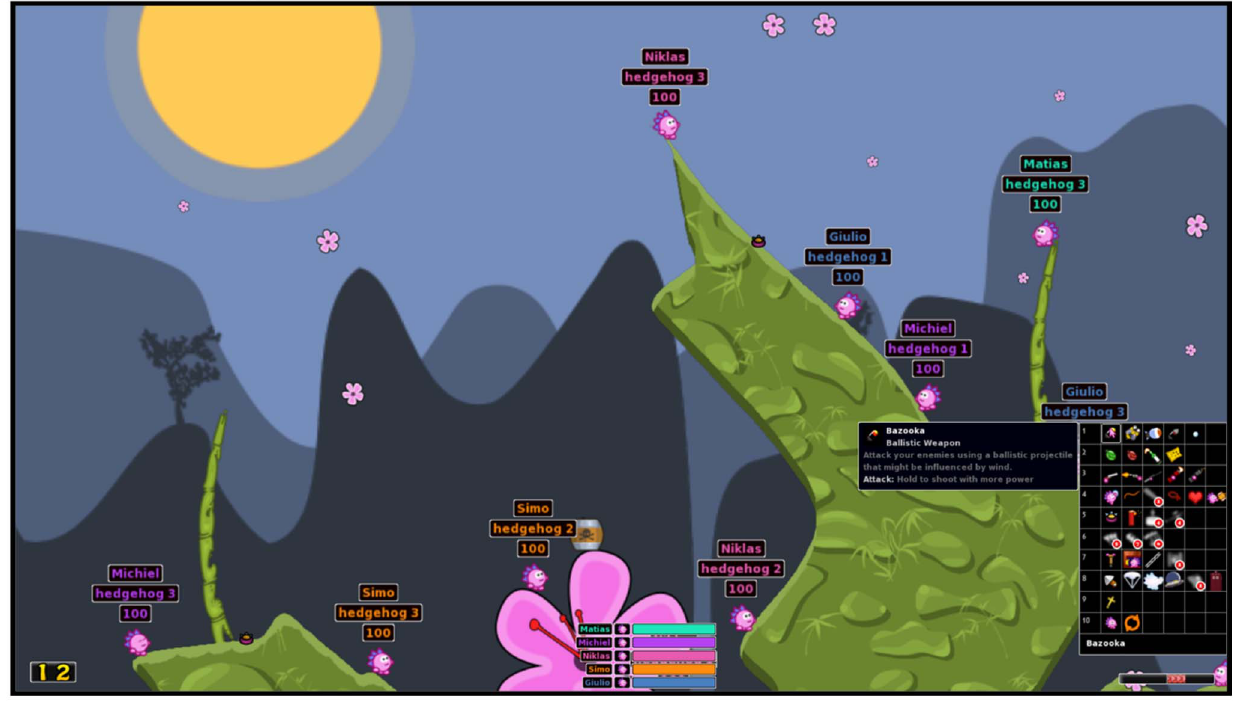
Figure 1. A screen-capture of Hedgewars. Participants commanded teams of hedgehogs and engaged in ballistic shooting (weapon choices are portrayed in the menu on the right) with or against other players.